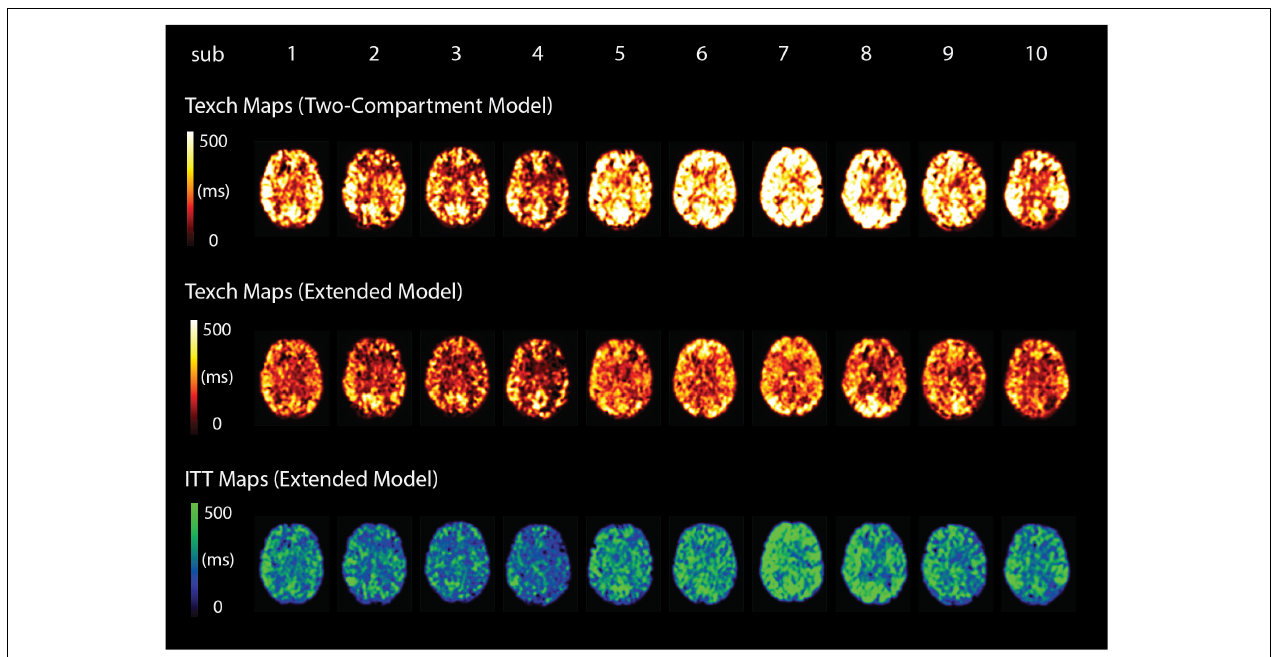
Frontiers in Neuroscience |